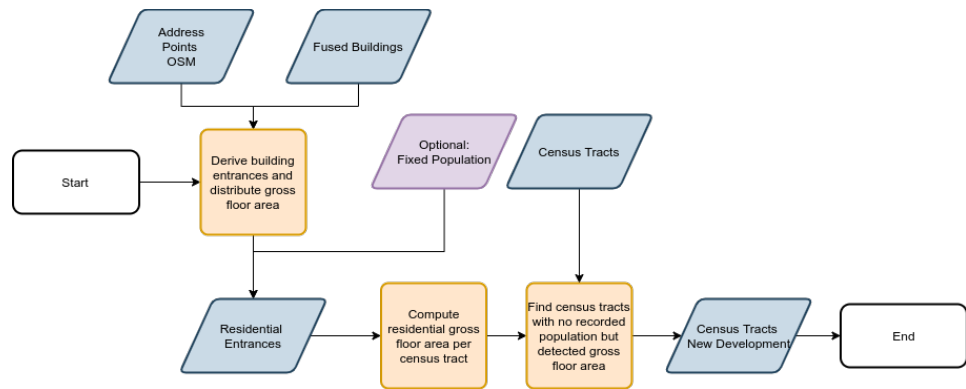
Figure 10. Detection of building entrances and New development